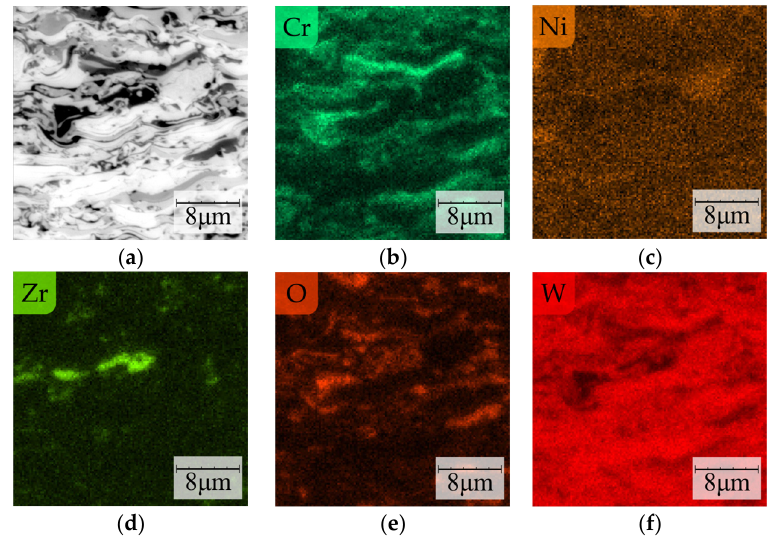
Figure 7. The cross-section of selected area in developed coating ( a ) and elemental mapping of Cr ( b ), Ni ( c ), Zr ( d ), O ( e ), and W ( f ).